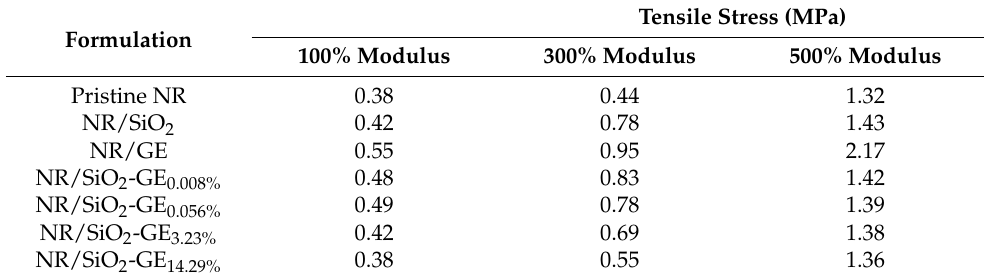
Table 7. Tensile strength value for EB-irradiated NR/SiO 2 -GE nanoplatelets. Dose: 150 kGy [152].